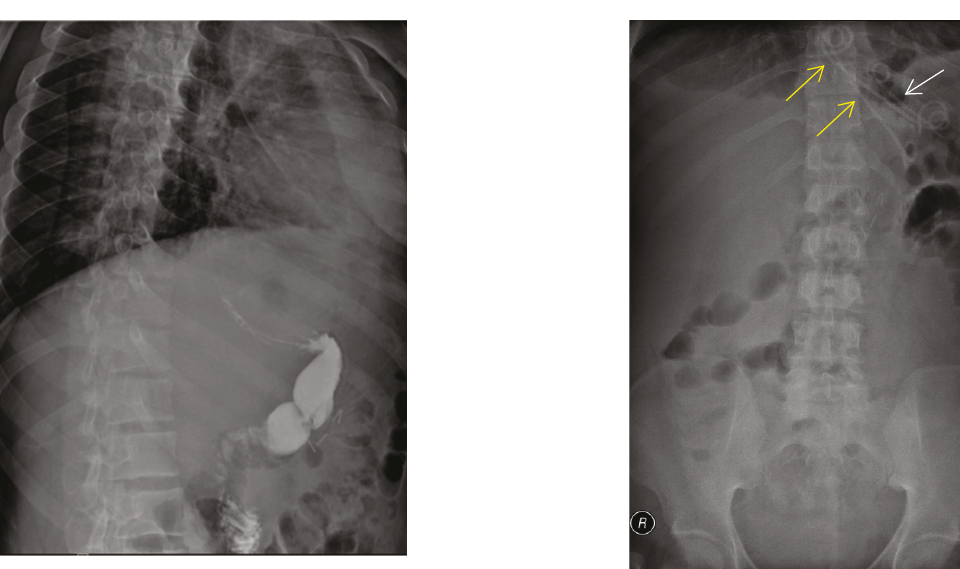
Figure 2: Upper gastrointestinal series with Gastrogra fi n swallow showing no leakage.